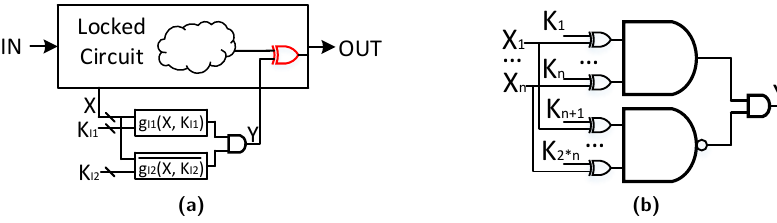
Figure 1: (a) Integration of Anti-SAT into a circuit. (b) Anti-SAT implemented with AND and NAND